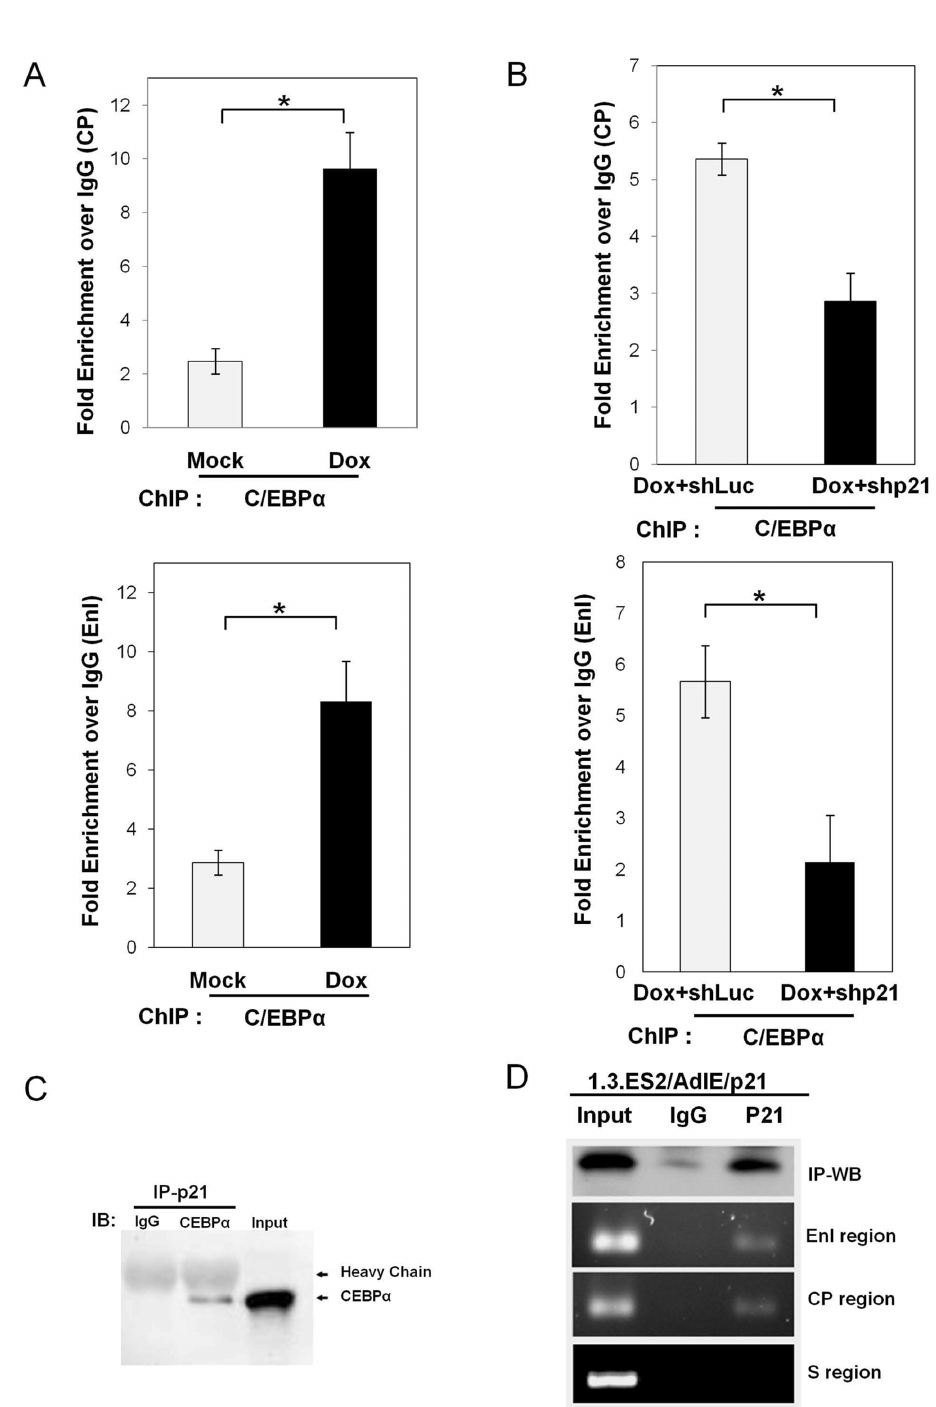
Fig 5. Binding of C/EBP α to the HBV promoter(s) is modulated by doxorubicin and p21. (A) Doxorubicin enhances C/EBP α recruitment to CP and EnI. 1.3.ES2 cells and doxorubicin-treated 1.3.ES2 cells were harvested in order to carry out ChIP assays. The nuclear extracts were co-incubated with IgG or anti-C/EBP α antibody and the content of the enriched chromatin fragments obtained were analyzed by quantitative RT-PCR. (B) P21 modulates C/EBP α recruitment to CP and EnI in doxorubicin-treated 1.3.ES2 cells. 1.3.ES2 cells were infected with lentivirus expressing p21 shRNA or control shRNA (shLuc) and this was followed by doxorubicin treatment. The nuclear extracts were harvested for ChIP analysis of the